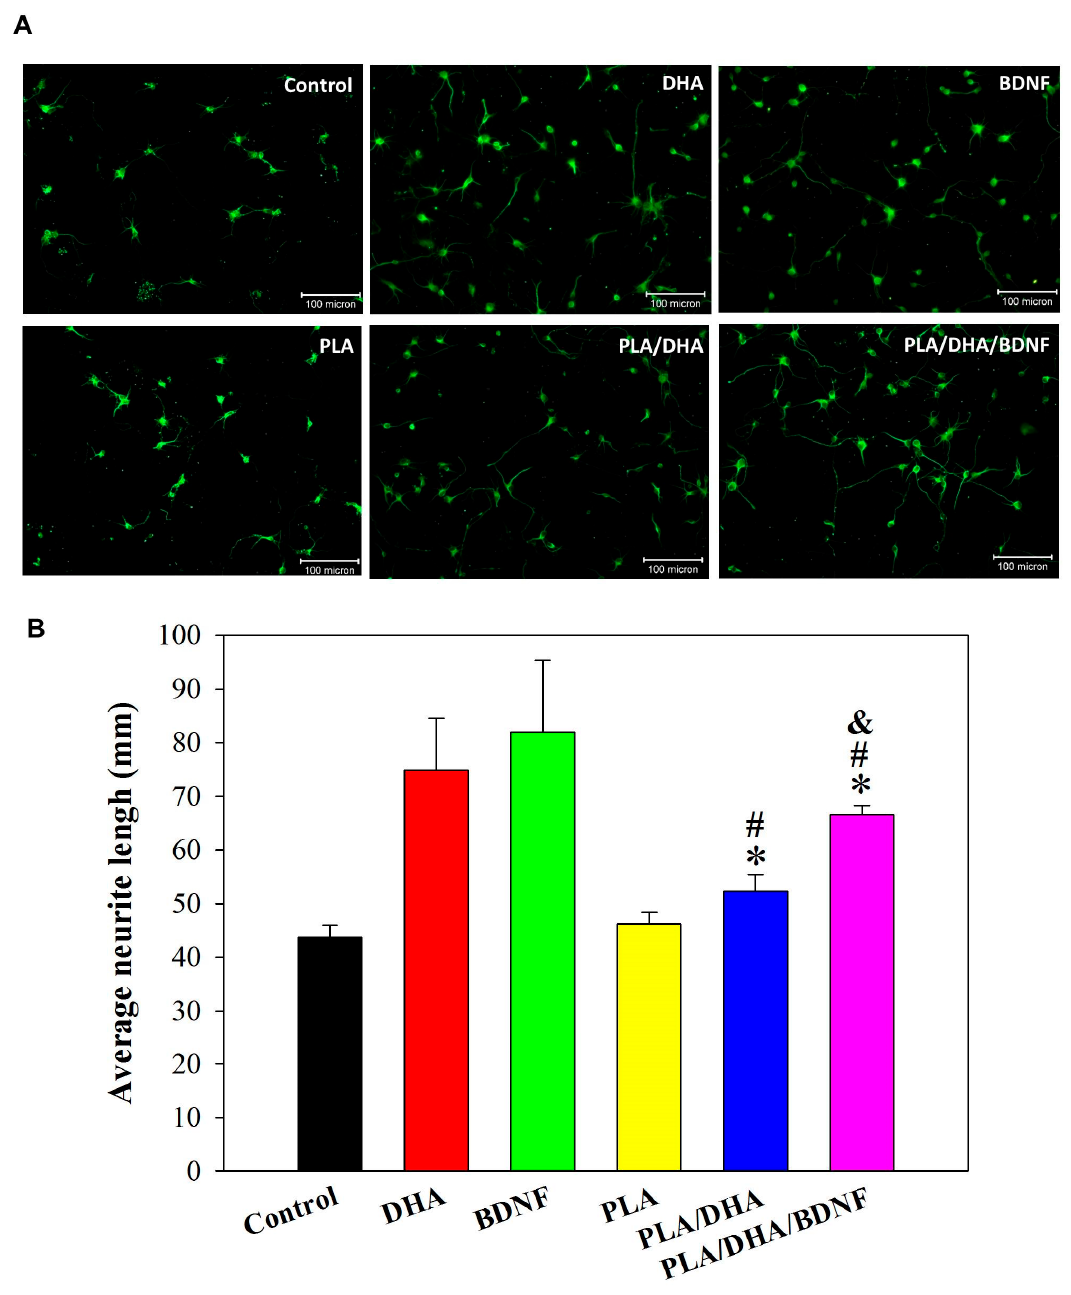
Figure 6. ( A ) The observation of neurite outgrowth from β -tubulin-III-positive primary cortical neuron from fluorescent microscopy by culturing primary cortical neurons in cell culture medium containing 3 µ M DHA or 250 ng/mL BDNF, and co-culturing primary cortical neurons with aligned core–shell fibrous membranes (CSFMs) in culture medium for 3 days (bar = 100 µ m). ( B ) The average neurite length for each neuron from neurite outgrowth. * p < 0.05 compared with control; # p < 0.05 compared with PLA; & p < 0.05 compared with PLA/DHA.